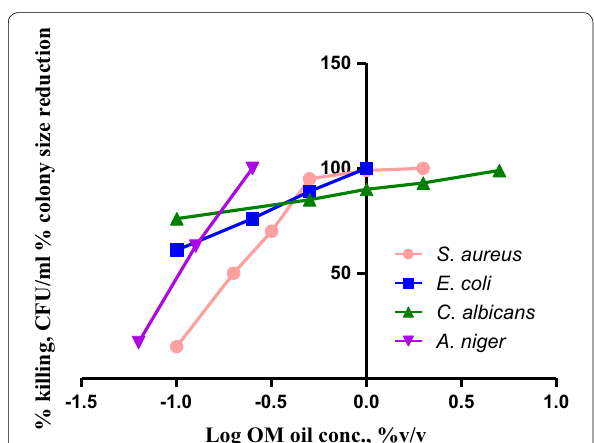
Fig. 3 Effect of OV EO on the biocidal activity against four selected